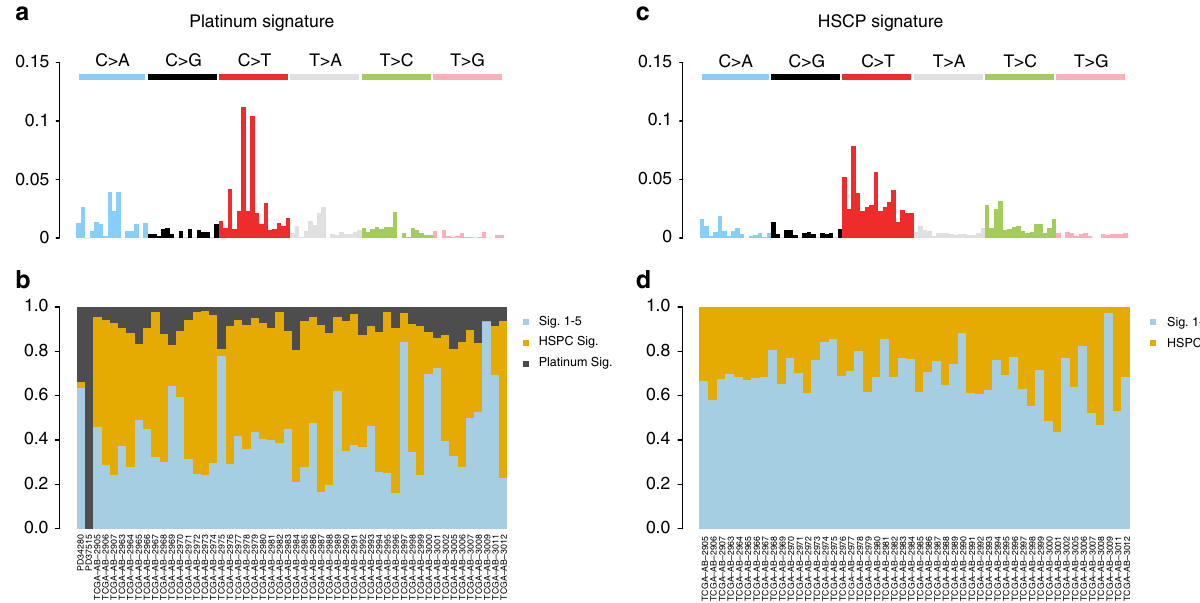
Fig. 7 Bleeding of signatures in AMLs. Example of inter-sample bleeding among 52 AML WGSs. a , b Running NNMF on the entire cohort, we extracted two mutational signatures not currently included in COSMIC: one recently associated with platinum exposure and the second recently reported as a process speci fi c to the hemopoietic stem cell (HPSC). c , d The inclusion of two t-AMLs (PD34280 and PD37515) affects the global signature extraction, with Platinum Signature extracted also in the primary AMLs. Removing the t-AMLs the inter-sample bleeding was corrected, and no Platinum Signature was extracted in primary AMLs. Sig. = signature